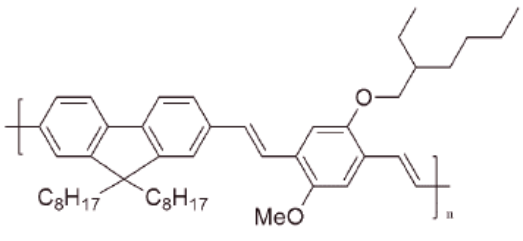
Figure 1. The molecular structure of the conjugated-polymer PFO- co -MEH-PPV (green polymer, GP). The absorption and the fluorescence spectra were measured for the GP in different concentrations. The spectra for the solutions were measured using a small quartz cuvette with